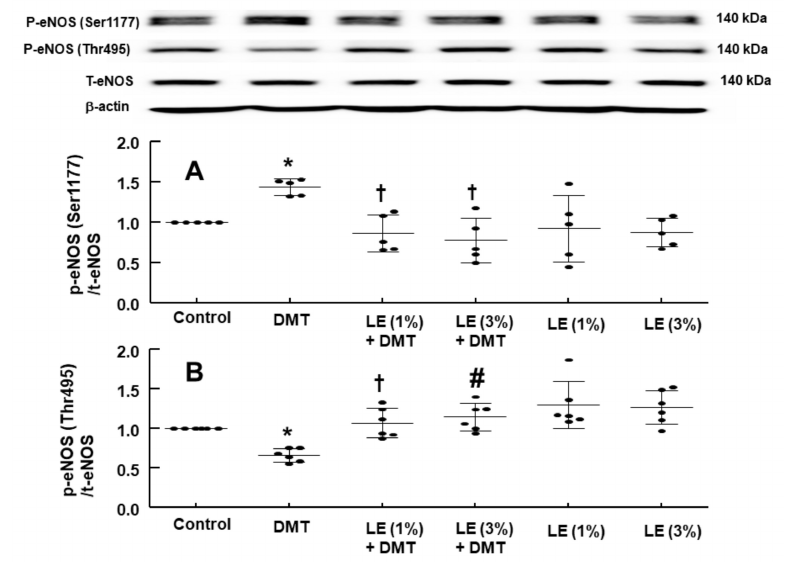
Figure 6. Effect of lipid emulsion (LE) and dexmedetomidine (DMT), alone or in combination, on stimulatory and inhibitory endothelial nitric oxide synthase (eNOS, Ser1177 ( A ) and Thr495 ( B )) phosphorylation in human umbilical vein endothelial cells (HUVECs). HUVECs were treated with DMT (10 − 6 M) alone for 5 min and with LE (1% and 3%) for 1 h, followed by treatment with DMT (10 − 6 M) for 5 min or LE (1% and 3%) alone for 65 min. Data ( n = 3) are shown as mean ± standard deviation. n indicates the number of independent experiments. * p < 0.05 versus control. † p < 0.01 and # p < 0.001 versus DMT alone. P-eNOS, phosphorylated eNOS; T-eNOS, total eNOS.